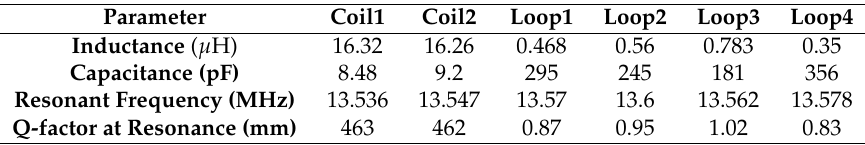
Table 2. Measured parameters of the coils and